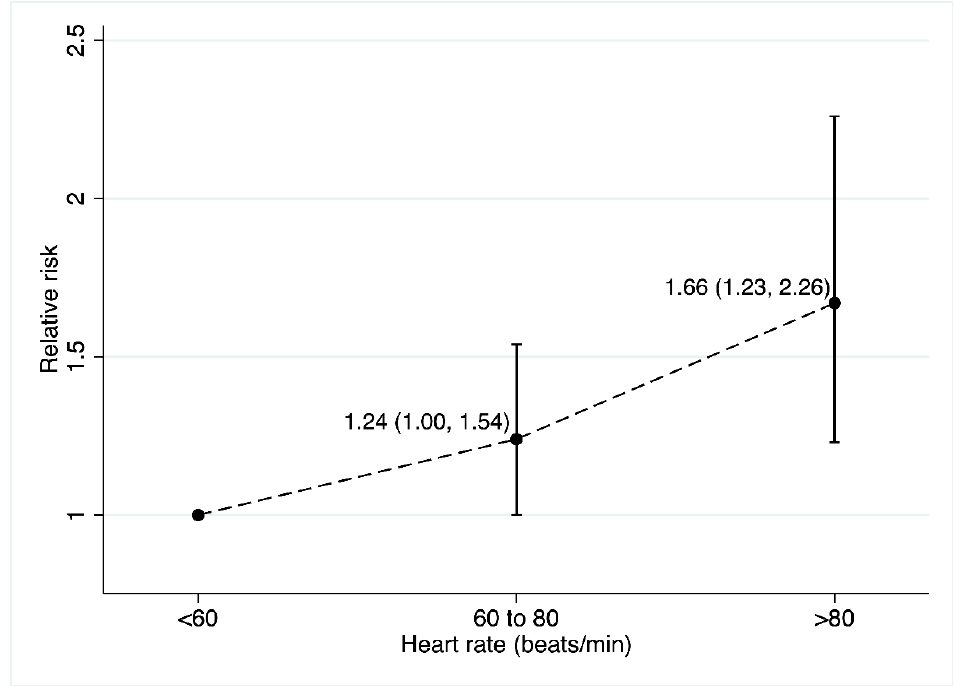
Figure 3. Relative risk (RR) of cancer mortality comparing the less than 60 beats per minute (bpm) category with 60 to 80 bpm and more 80 bpm categories.